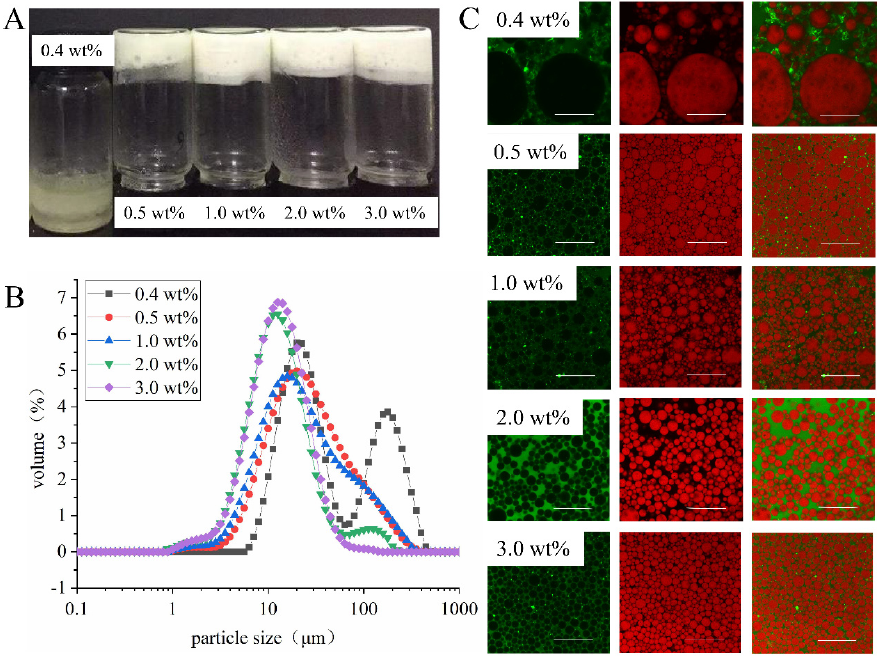
Figure 6. The visual observation ( A ), particle size distribution ( B ), and CLSM images ( C ) of HIPEs stabilized by EYGs at different concentrations. The NaCl ionic strength was 0.3 M, and the volume of the oil phase was 0.8. The corresponding bar is 100 µm.